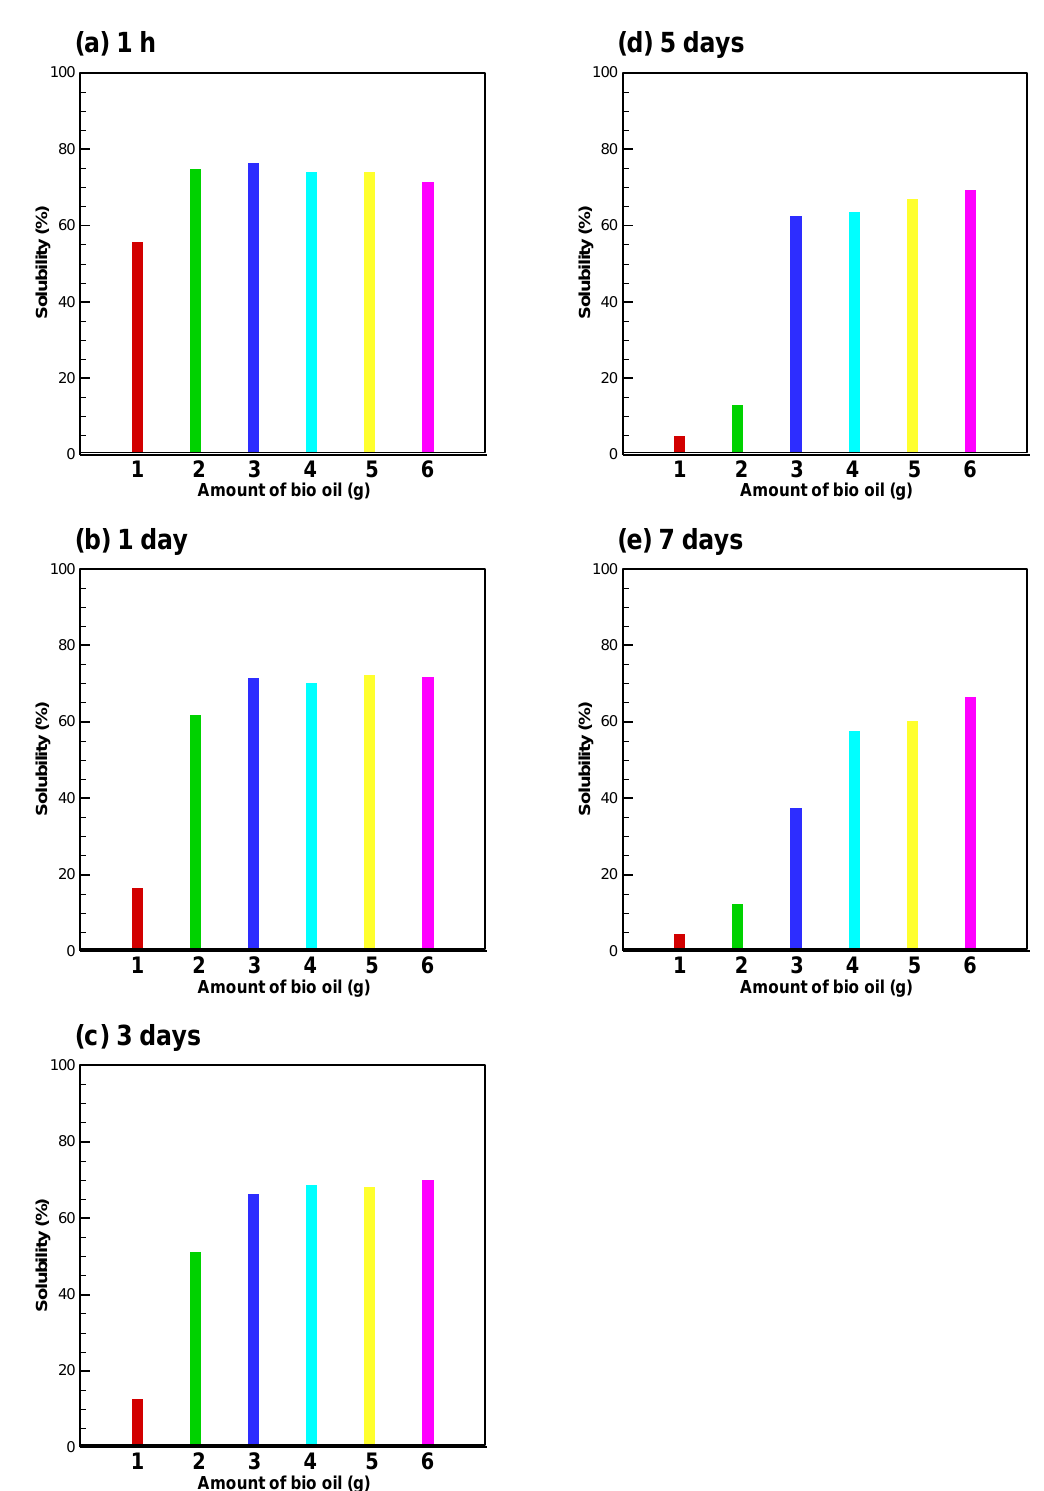
Figure 3. The solubility of the emulsions with different bio-oil amounts (B/E = 1) ( a ) 1 h, ( b ) 1 day, ( c ) 3 days, ( d ) 5 days, and ( e ) 7 days.